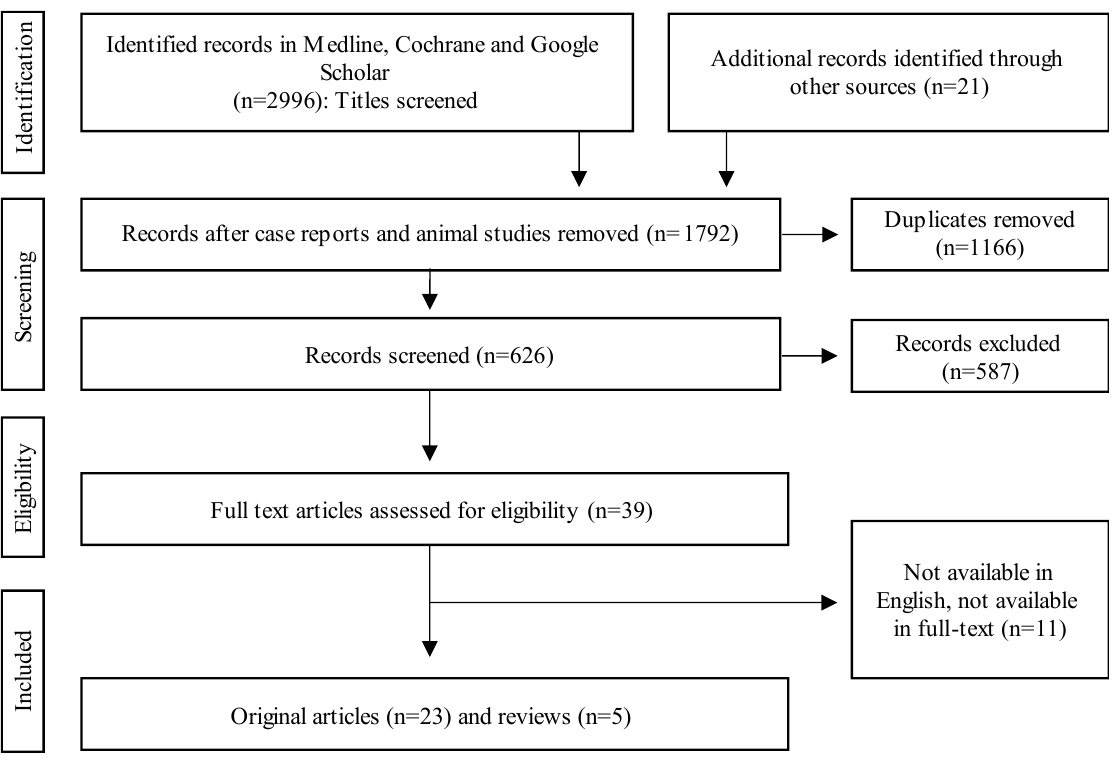
Figure 1. PRISMA flowchart of data extraction.